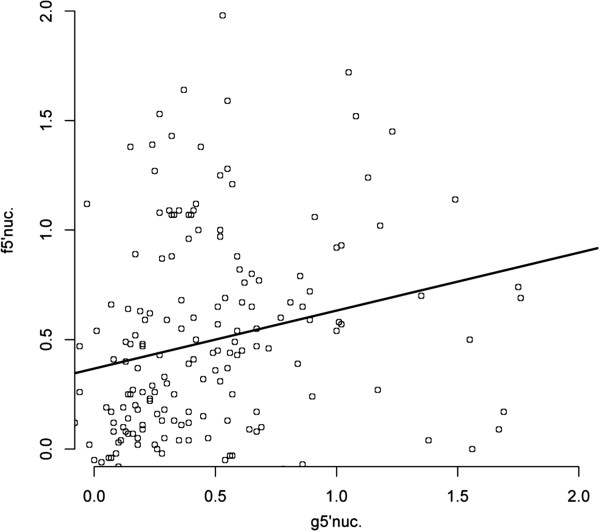
Correlation of IgG responses between 5′nucleotidase ortholog recombinant proteins from two distinct Anopheles species. A scatter plot analysis of IgG response to f-5′nuc is presented, and the aOD values among the 134 exposed individual are reported. For g-5′nuc and f-5′nuc measurements, the best-fit is shown as a black line (slope 0.1245±0.1036), with a Spearman’s rank correlation coefficient (rho) of r = 0.1635, p>0.05 (p=0.0591).